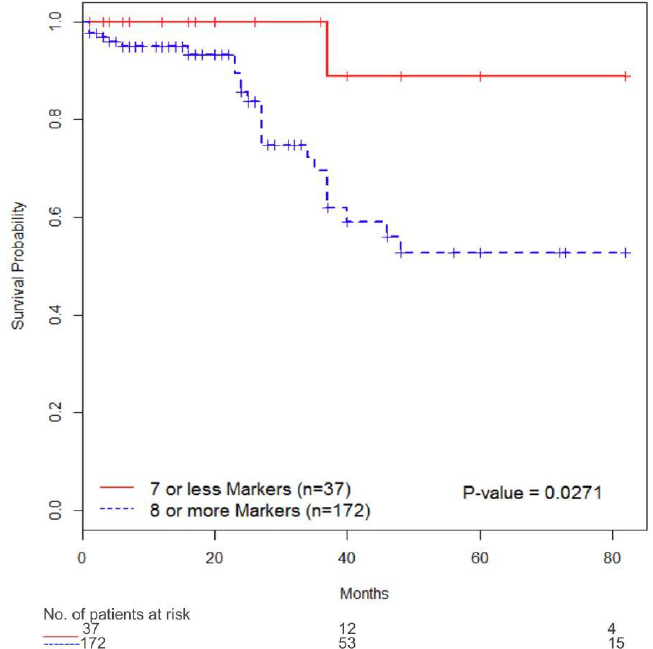
Figure 3. Overall survival analysis of 213 patients with bladder cancer. Overall survival according to immunostaining status of ≥8 targets from diagnostic signature and < 8 targets from diagnostic